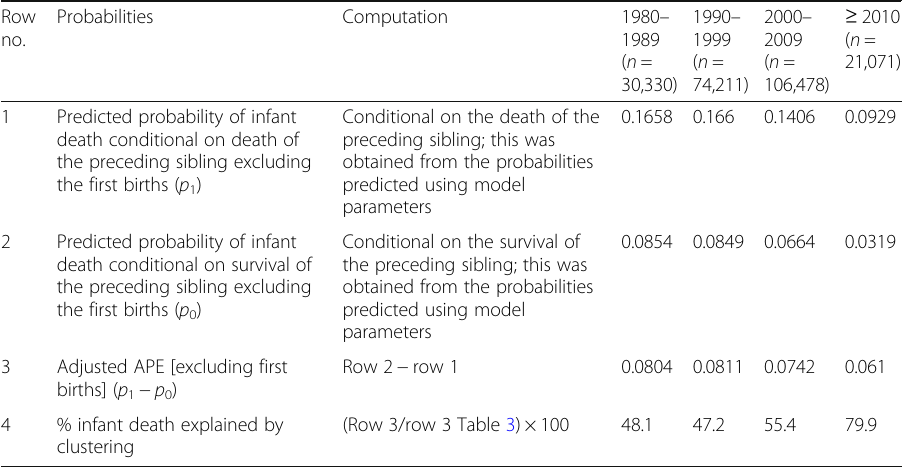
Table 4 Adjusted contribution of death clustering to infant mortality in Nigeria, 1980 – 2013 Row